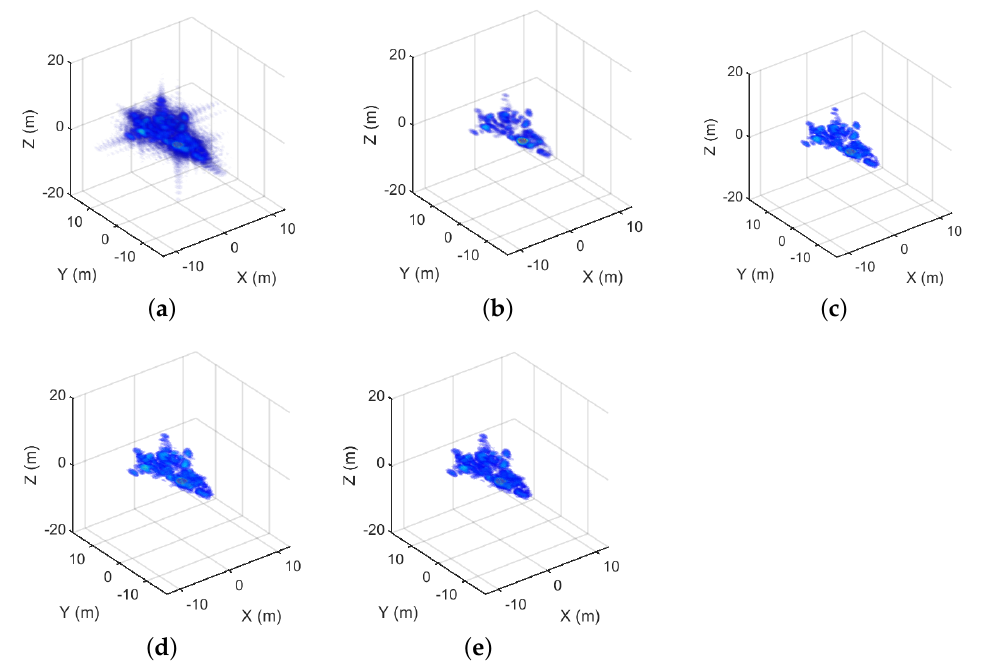
Figure 10. The imaging results of the aircraft with SNR of 15 dB. ( a ) The MF result. ( b ) The FIST result. ( c ) The SCAD result. ( d ) The MCP result. ( e ) The GSALSA–Cauchy result.